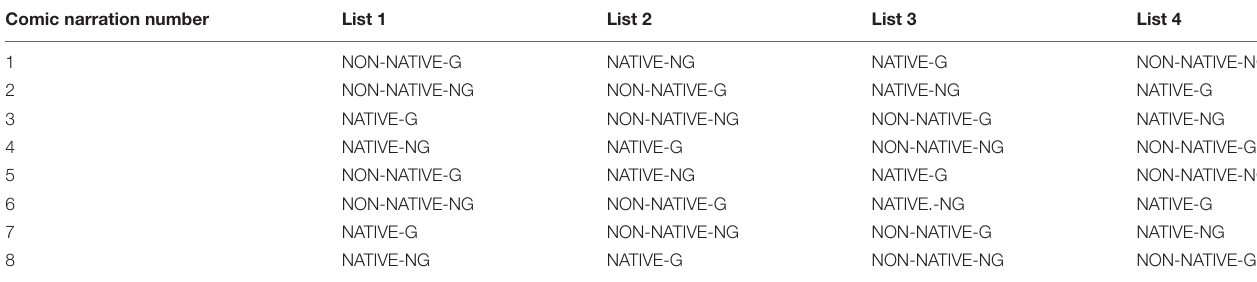
TABLE 2 | The distribution of language and gesture conditions by comic narration into four counter-balanced lists. Comic narration number List